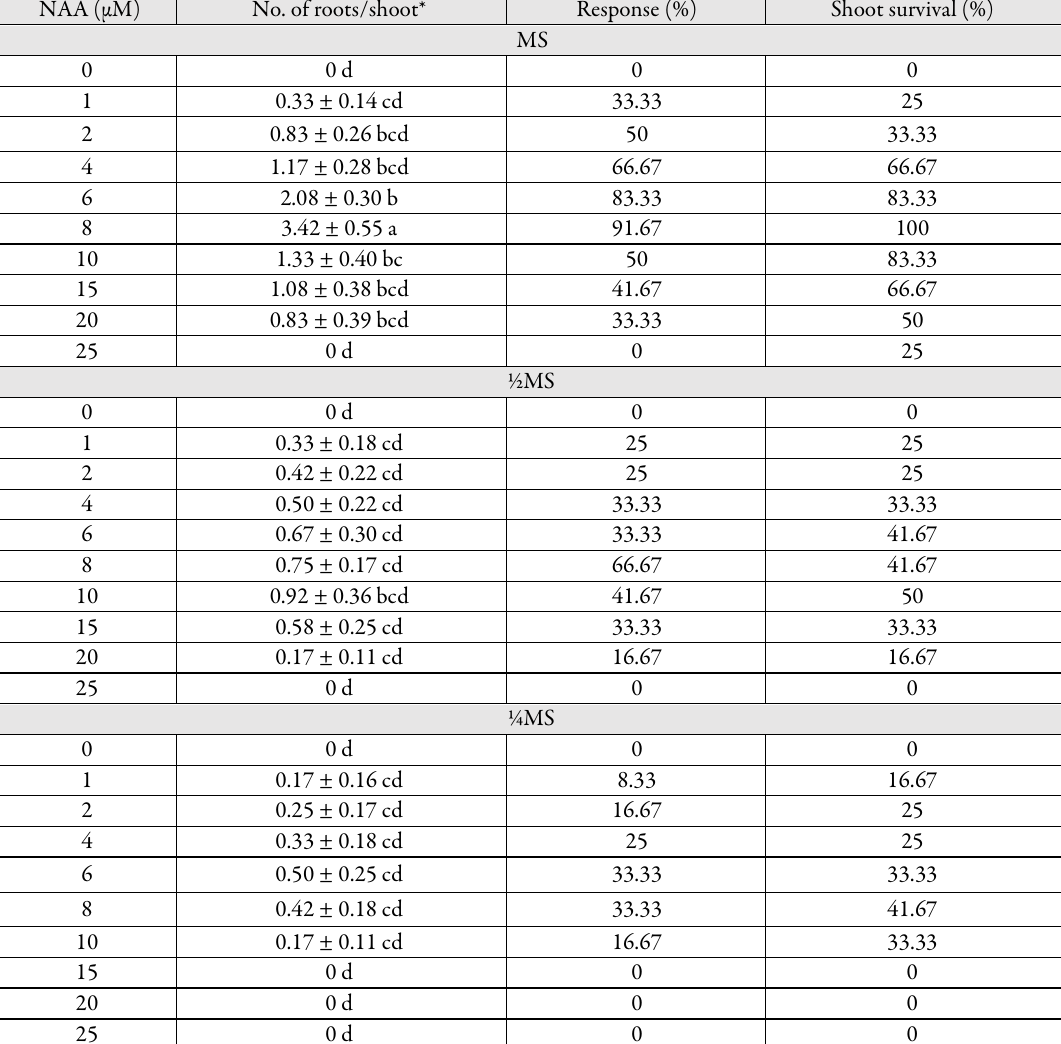
Table 2. Effect of different strengths of MS medium and concentrations of NAA on root formation in H. indicus shoots (4 weeks)